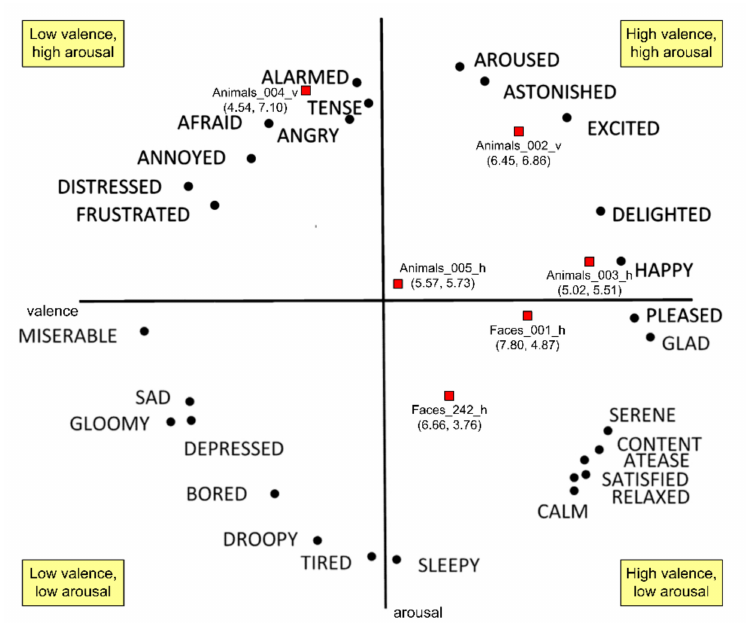
Figure 1. The circumplex model of emotion as described in [17]. Valence ( val ) represents x -axis and arousal ( ar ) y -axis. Red points mark pictures from the experimental dataset listed in Table 1. Approximate ( val , ar ) coordinates of basic emotions in the dimensional emotion model space Ω Emo are indicated.